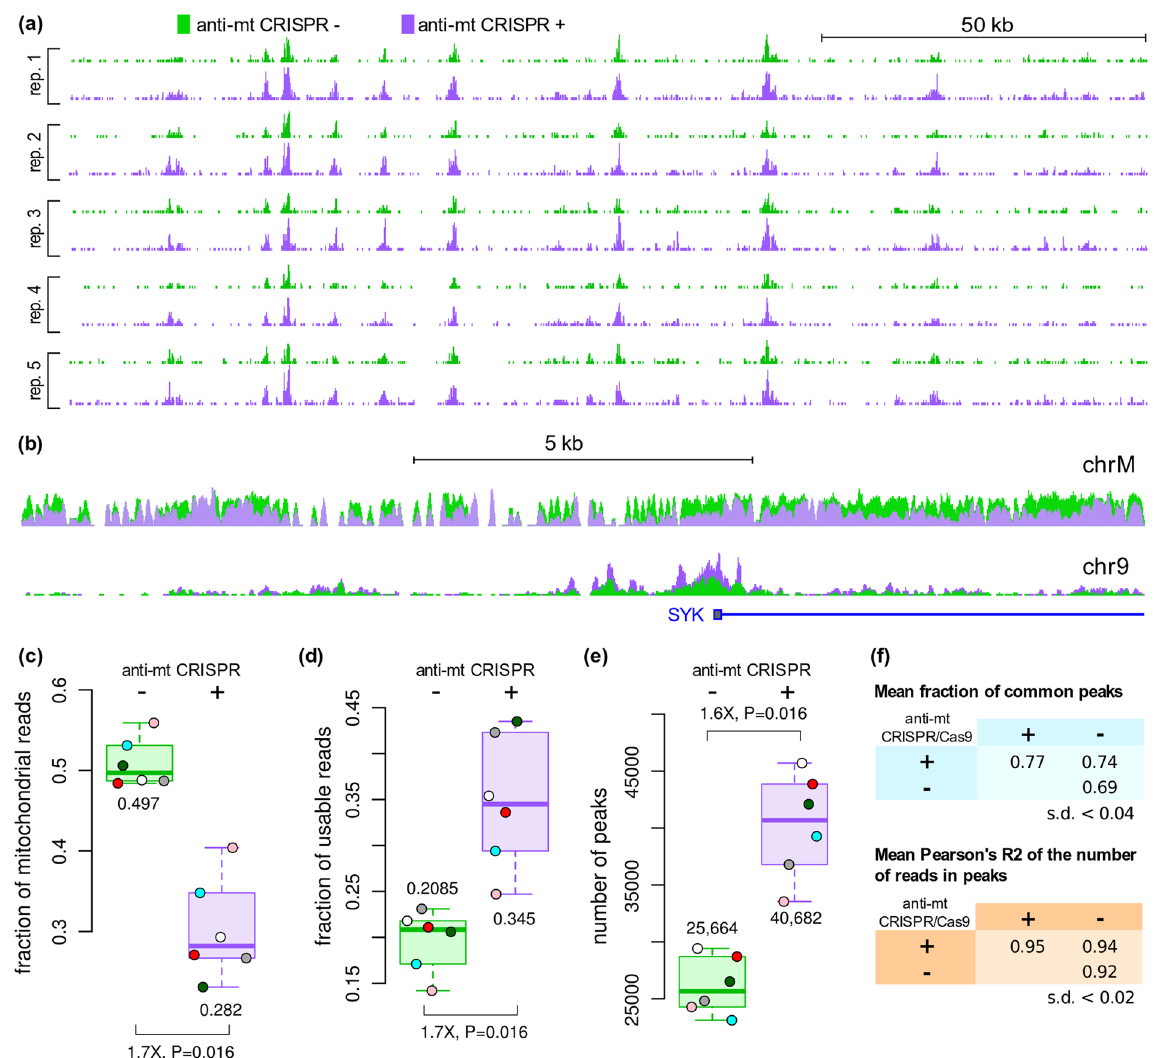
Figure 2. ATAC-seq was performed on human lymphoblastoid cells and half of each sample was left untreated (green) and the other half was treated with anti-mt CRISPR (purple). ( a ) Representative genomic region (hg38, chr2:74,425,417–74,586,546) showing read counts (usable reads) in 5 replicate pairs (DT) at the same sequencing depth of 21.9 M reads. Differences between treated and untreated samples were minimal, indicating that the treatment did not damage the samples. ( b ) ATAC-seq reads in the mitochondrial chromosome and in a 16.5 kb region of chromosome 9 around the SYF promoter (same as Fig. 1). For each condition, all samples were pooled together and 227 M reads were sampled. ( c ) Treated samples yielded 1.7-fold fewer mitochondrial reads compared to untreated samples. ( d ) Accordingly, the number of unique, non-mitochondrial (usable) reads was 1.7-fold higher in treated samples than in their untreated counterparts. ( e ) At the same sequencing depth, 1.6-fold more peaks were called in the treated samples. Only 6 data points are shown because the treated halves of samples 18 and 19 (same batch) had only 14.5 M and 9.8 M reads each and were combined for improved peak calling. ( f ) Anti-mt CRISPR-treated samples shared a similar number of peaks with treated replicates and untreated samples. The top 20,000 peaks of each sample were used in this analysis. Comparison of peaks at the read count level also supports that peaks from treated samples do not substantially differ from untreated samples. Fold-differences were calculated on the medians. ( c–e ): all samples normalized to 21.9 M sequenced